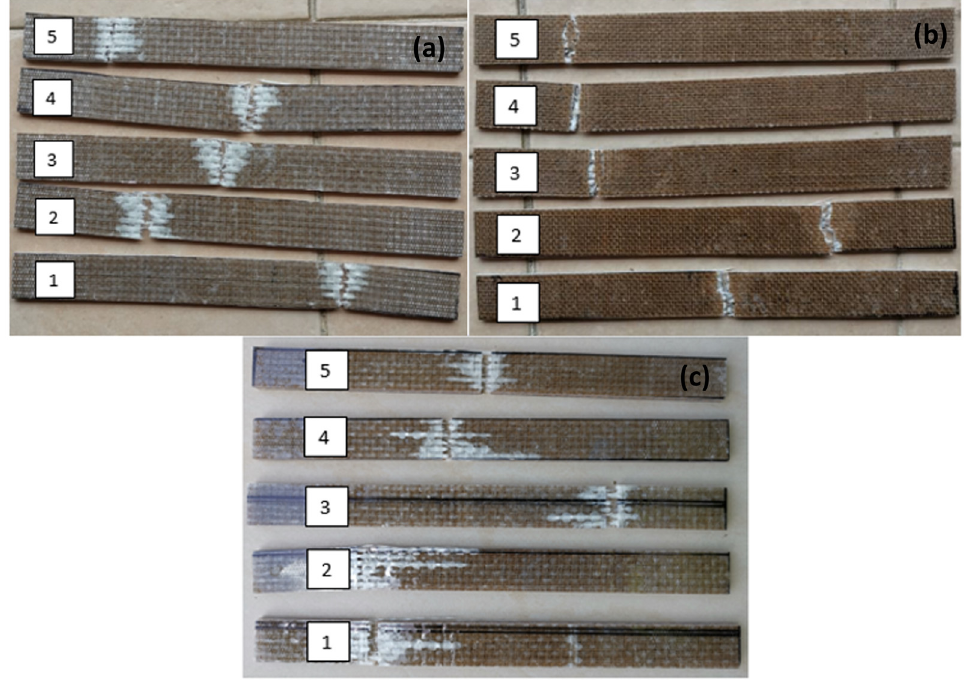
Figure 2: Composite sample after tensile testing: ( a ) GKGKG, ( b ) KGKGK, and ( c )